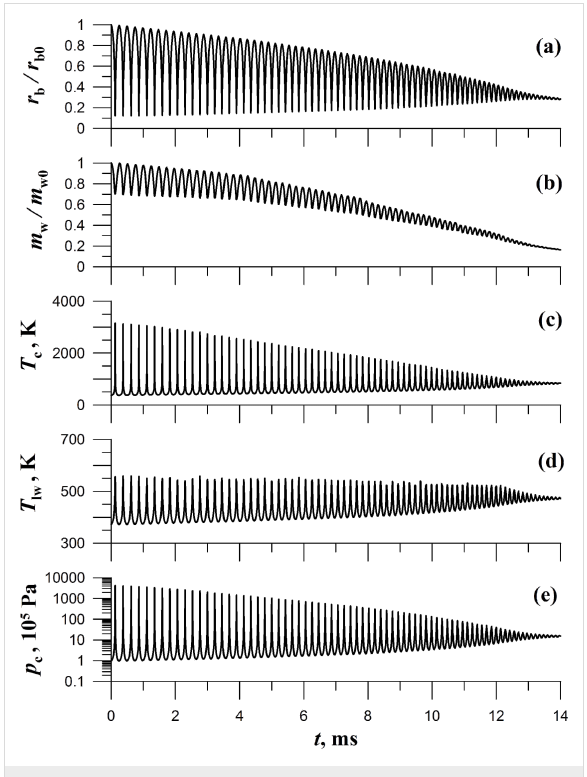
Figure 2: Time dependencies r b /r b0 , m w / m w0 , T c , T lw , and p c in a pulsating cavitation bubble. Initial parameters are the bubble radius r b0 = 0.5 cm, the pressure inside the bubble p 0 = 10 5 Pa, the vapor temperature T 0 = 373 K. The pressure in the liquid far from the bubble is p ∞ = 15 p 0